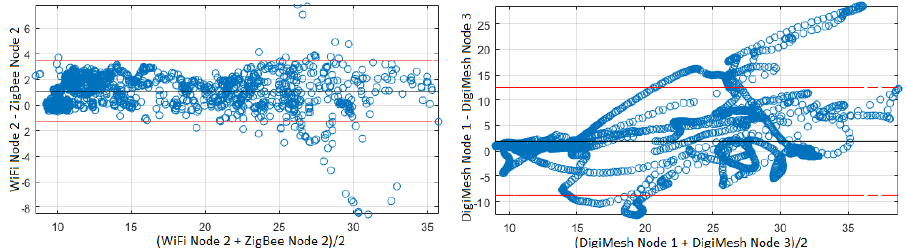
Figure 15. Bland–Altman plots of air temperature: ( left ) nearby sensor nodes; and ( right ) distant sensor nodes. This representation shows that the first case corresponds to measurements from very similar phenomena, whereas the second one corresponds to measurements from a complex-dynamics system which nevertheless are intrinsically related.